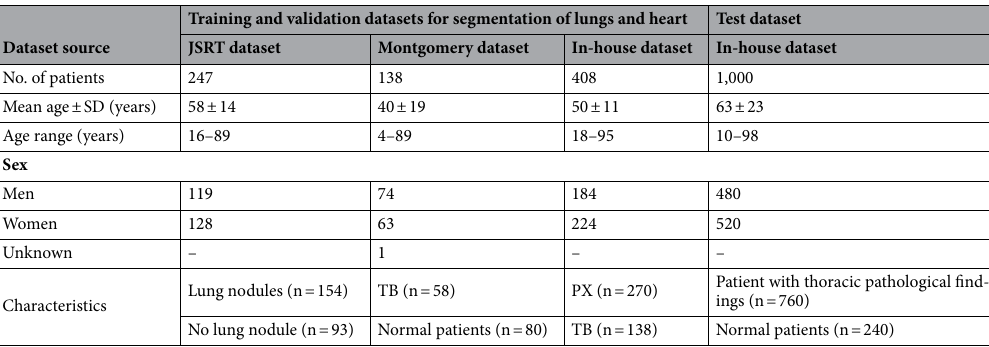
Table 1. Data and patient characteristics. JSRT Japanese Society of Radiological Technology, SD standard deviation.